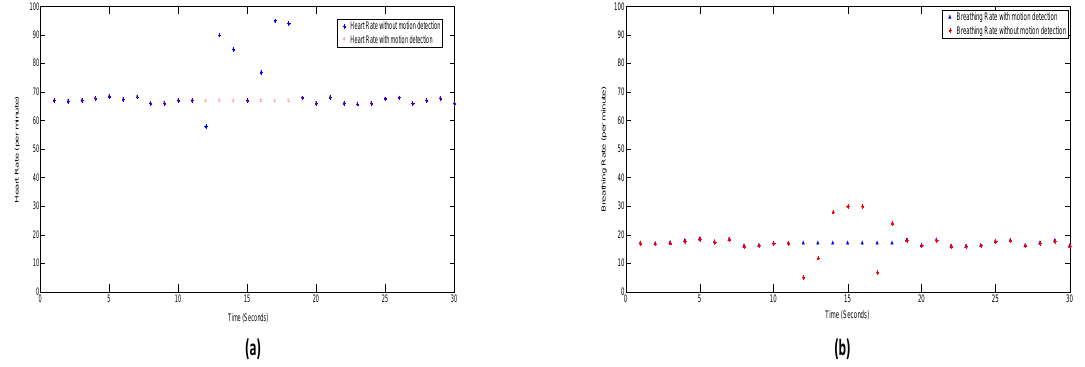
Figure 11. Results of vital signs: ( a ) with and ( b ) without motion detection algorithm.